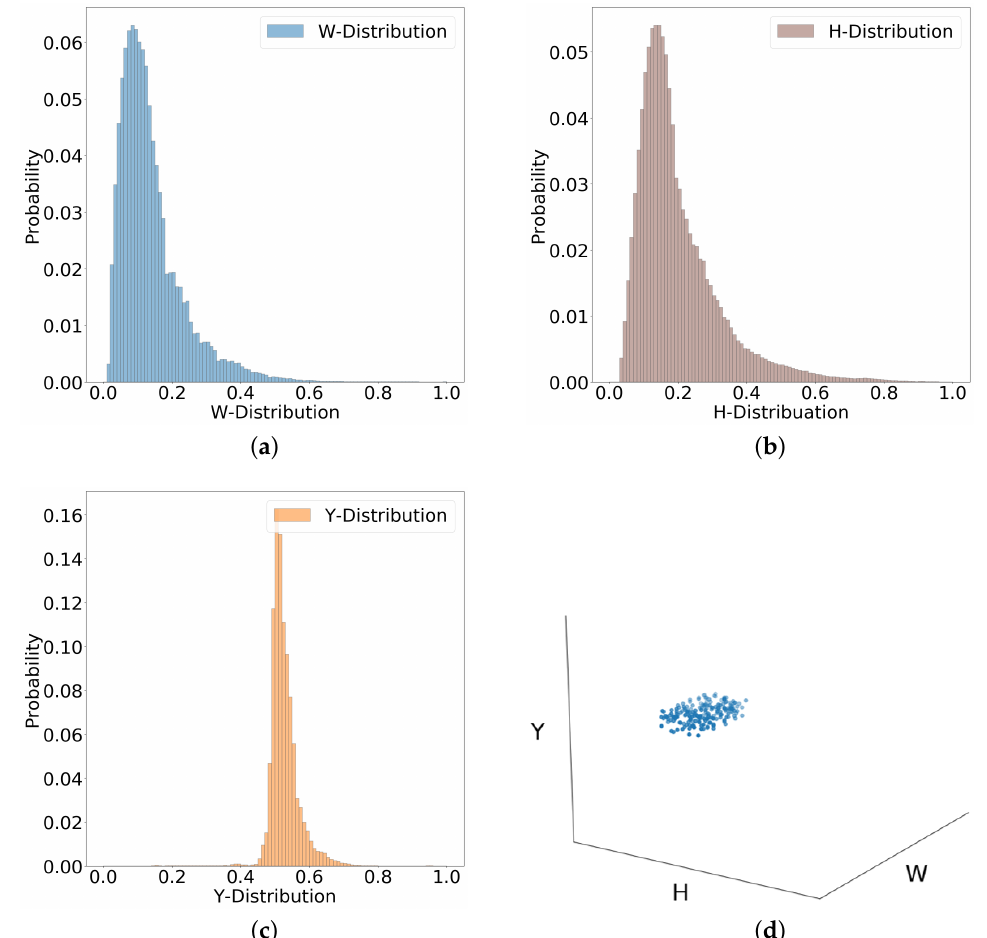
Figure 2. Multivariate distribution for generating random samples. ( a ) W-distribution. ( b ) H- distribution. ( c ) Y-distribution. ( d ) Random samples